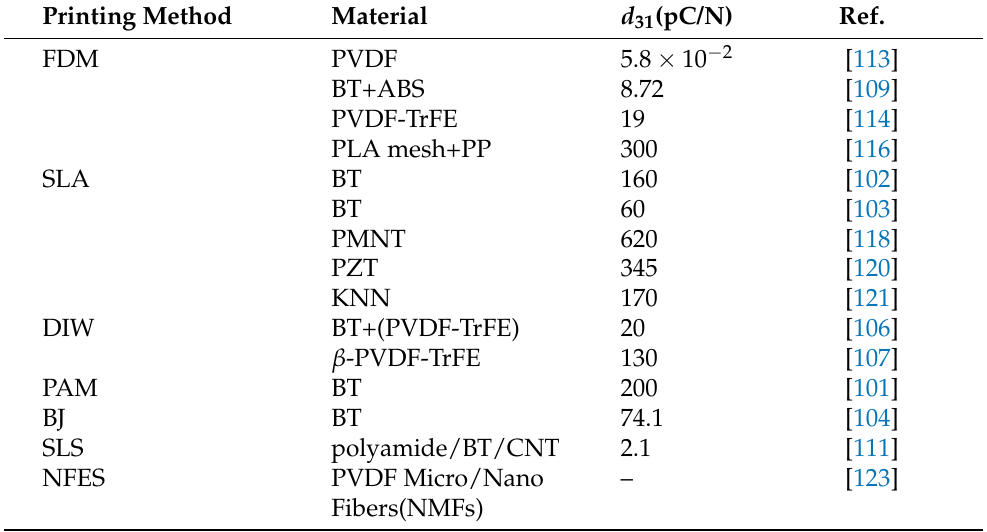
Table 5. Comparison of 3D printed piezoelectric materials with various 3D printing